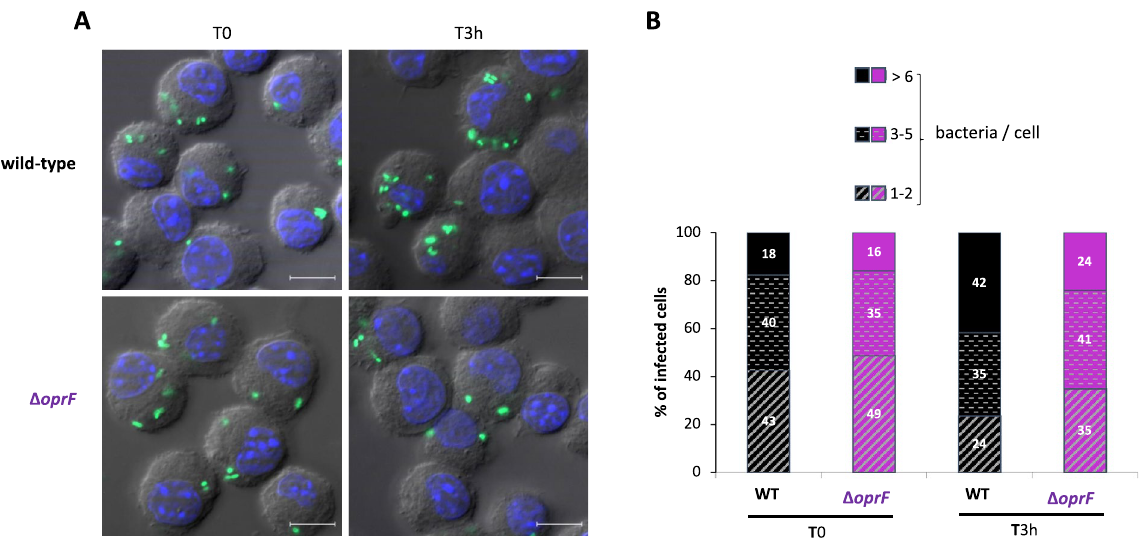
Figure 3. Visualization and quantification of intracellular P. aeruginosa within macrophages. GFP-expressing PAO1 WT and ∆ oprF strains were used for infecting J774 macrophages. Cells were fixed after phagocytosis and 20 min (T 0 ) or 2.5 h (T 3h ) treatment with gentamycin and imaged with fluorescent microscope. DAPI was used to stain the nucleus. ( A ) Visualization of intracellular bacteria. The merged image shows Differential Interference Contrast (DIC), nucleus staining (blue) and bacteria expressing GFP (green). The scale bars depict 10 µm. ( B ) Count of the number of bacteria in infected macrophages from images obtained. The numbers of bacteria per cell were classified in three groups (1–2, 3–5 and > 6 bacteria per cell) and percentage of each class is shown. Count is done from 100 cells per condition and results are expressed as means from three independent experiments.